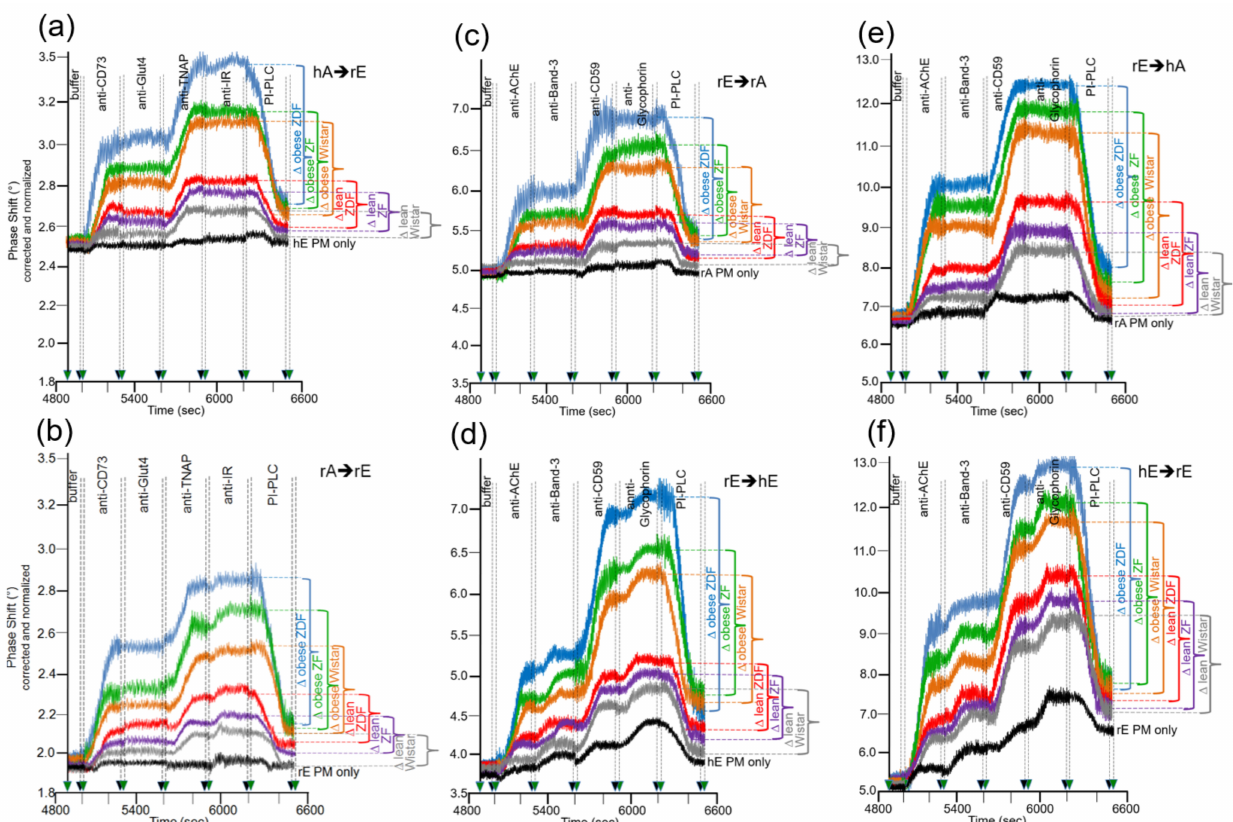
Figure 6. Chip-based sensing system for the transfer of full-length GPI-APs from donor to acceptor PM at various combinations of the six rat groups. ( a – f ) The experiment was performed as described for Figure 3 with injection of 400 µ L of donor PM (800–1200 s) at a flow rate of 60 µ L/min and subsequent incubation (until 4800 s, 60 min, 37 ◦ C) of the donor–acceptor PM combinations or acceptor PM only as indicated (donor PM → acceptor PM). At variance with Figure 3, injection of anti-CD55 antibody was omitted for the combinations with donor erythrocytes ( c – f ). The rat (r) donor and acceptor PM were derived from adipocytes (A) and erythrocytes (E) which had been prepared from the six rat groups. Phase shifts are shown only after termination of the transfer period/start of buffer injection (4800 s) and termination of PI-PLC injection (6500 s). ∆ phase shifts as measure for GPI-AP transfer are calculated as described for Figure